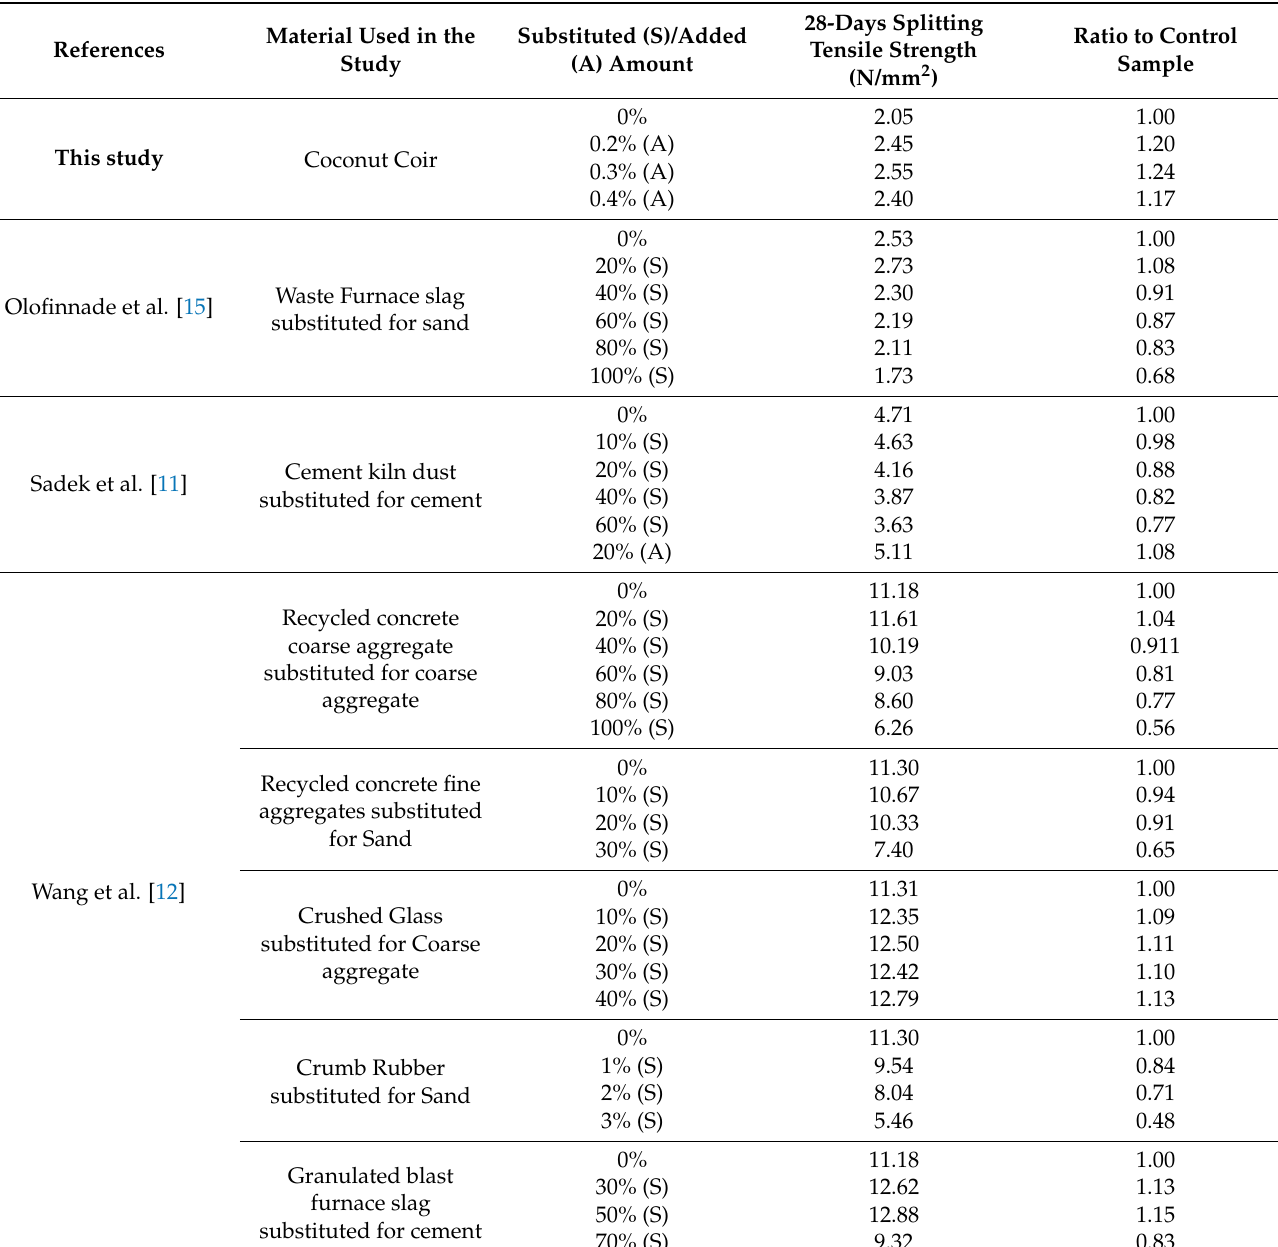
Table 11. Comparison of splitting tensile strength of IPBs with other